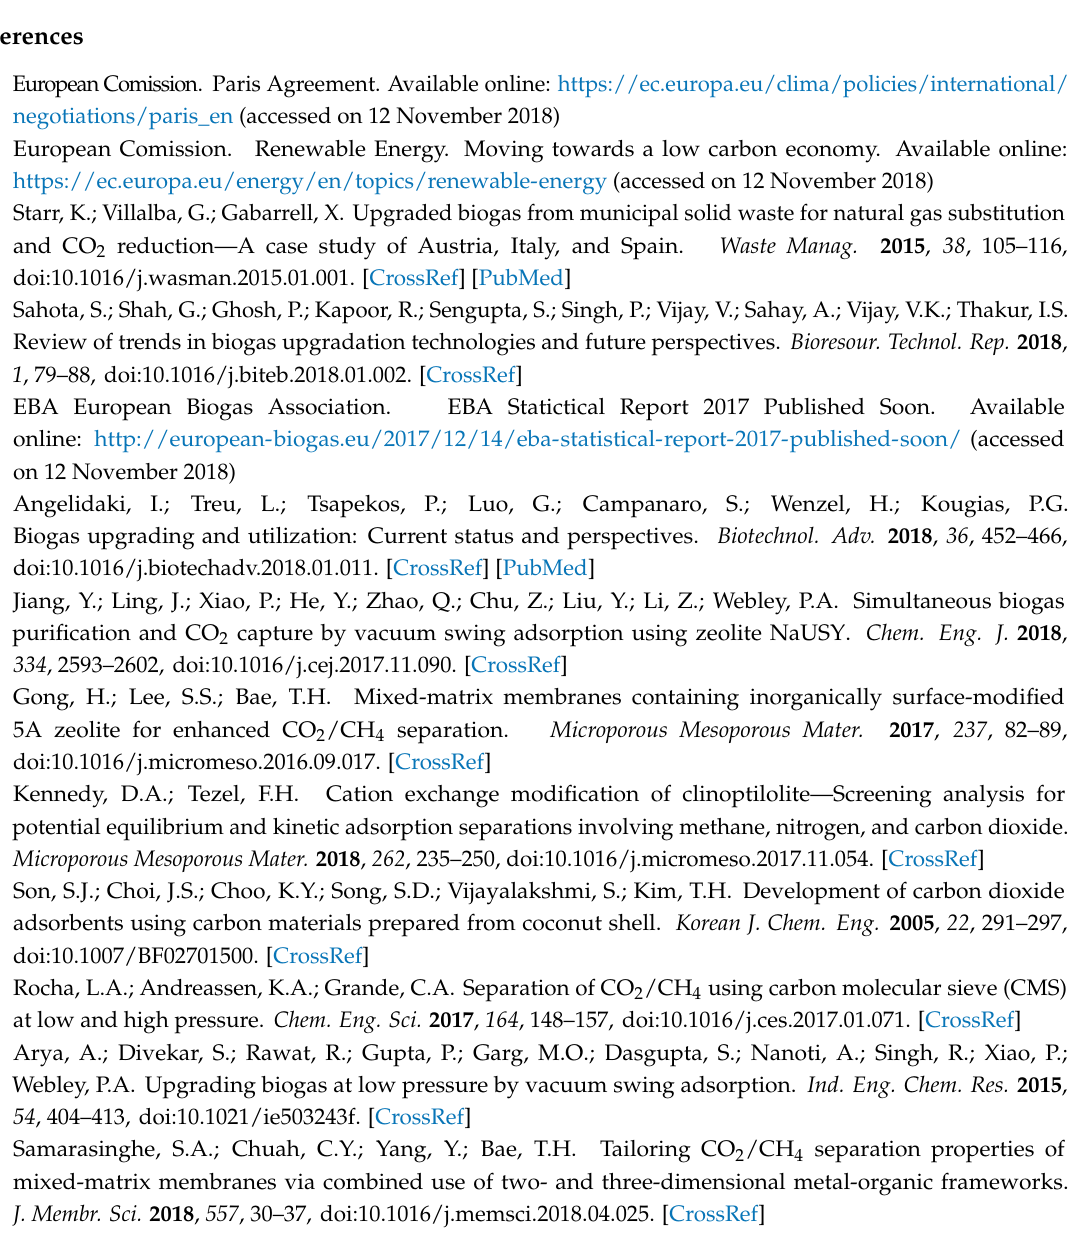
Figure S2: Pore size distribution (PSD) of the olive stone activated carbons obtained by means of density functional theory (DFT). Figure S3: Emitted CO 2 during temperature programmed desorption-mass spectroscopy (TPD-MS) of the olive stone activated carbons. Figure S4: Emitted CO during temperature programmed desorption-mass spectroscopy (TPD-MS) of the olive stone activated